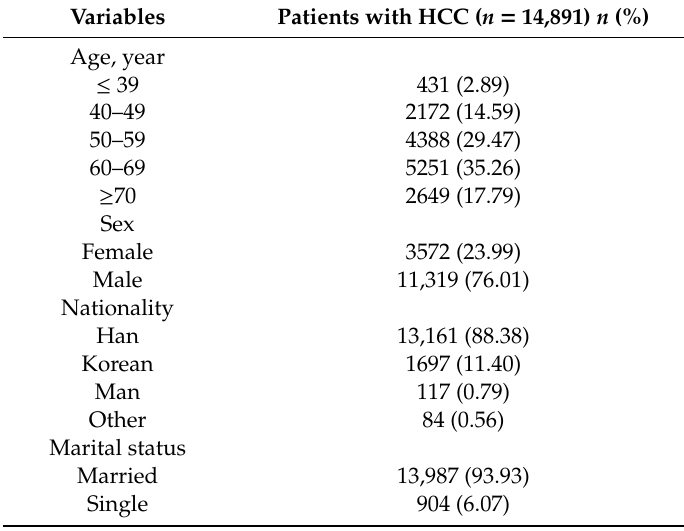
Table 1. Demographic characteristics of patients with hepatocellular carcinoma